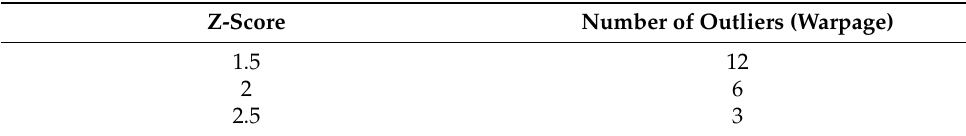
Table 6. Number of outliers versus z-score.